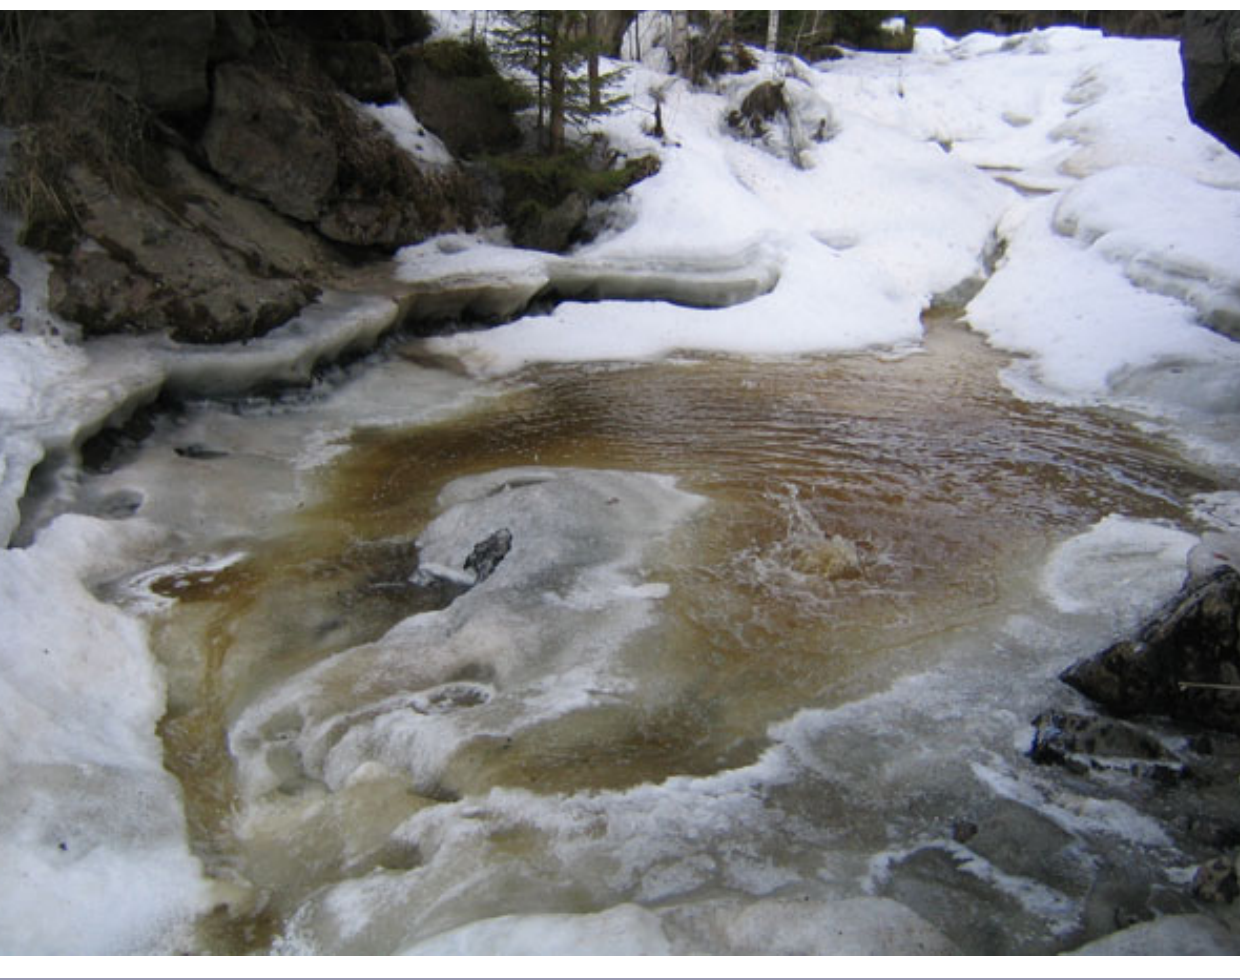
Fig. 2. Stream in which the bottom is covered by anchor ice, and the water is running on top of this ice, thus raising water levels. Such seasonal events may hamper biota in aquatic as well as riparian habitats and can serve as population bottlenecks for many species. Photo courtesy of Johanna